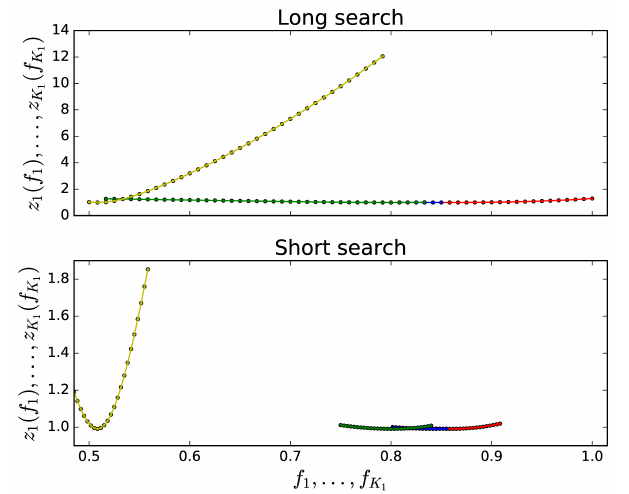
Fig. 6.— Model 27 for Table 3 data. Otherwise as in Fig. 3.